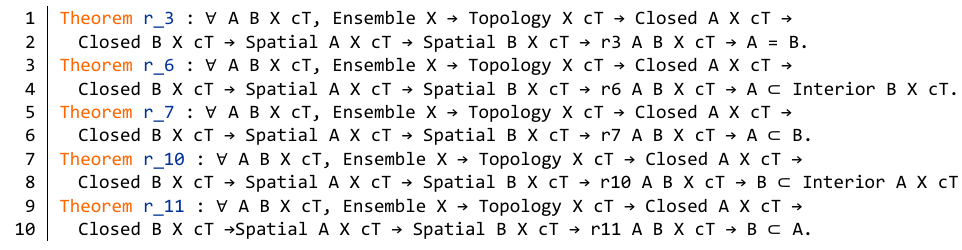
Figure 8. The formal description of Theorem 3 ( r 3 , r 6 , r 7 , r 10 , r 11